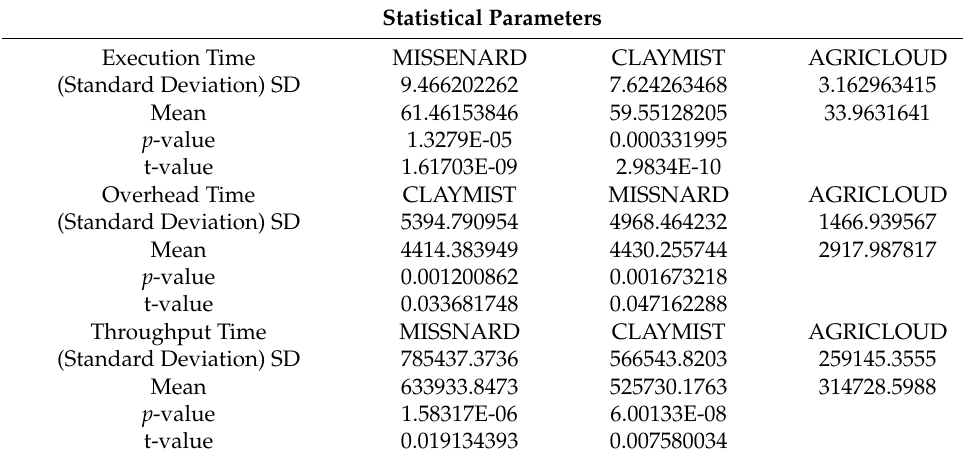
Table 5. Statistical analysis of AGRICLOUD with other